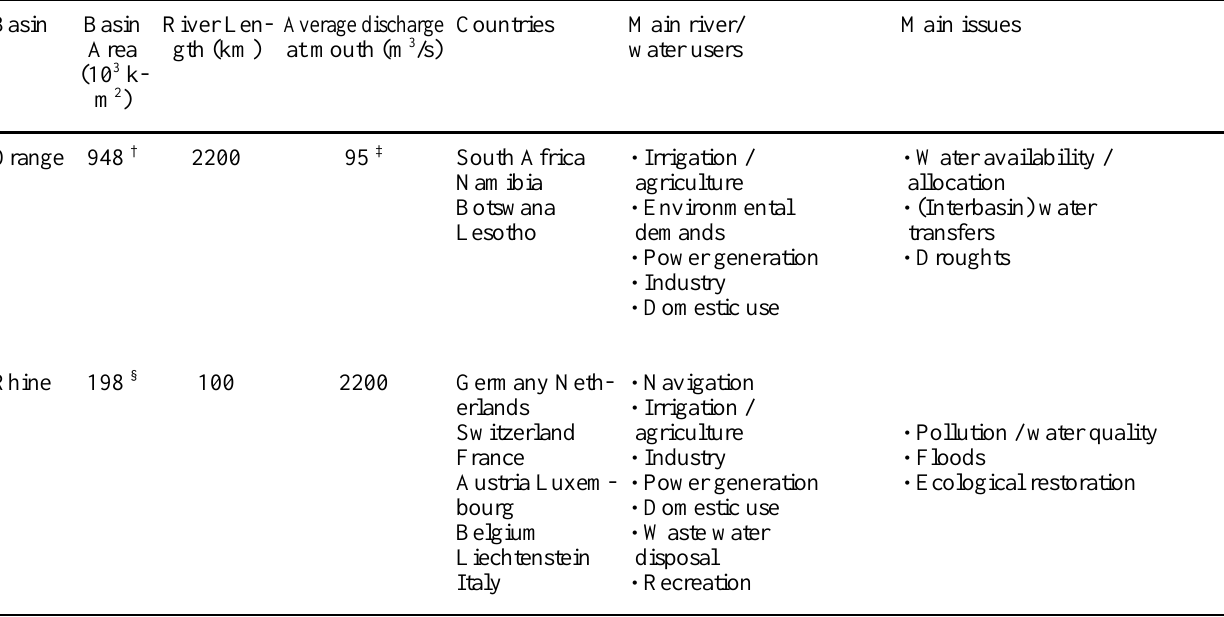
Table 2. Overview of main characteristics of the Orange and Rhine river basins